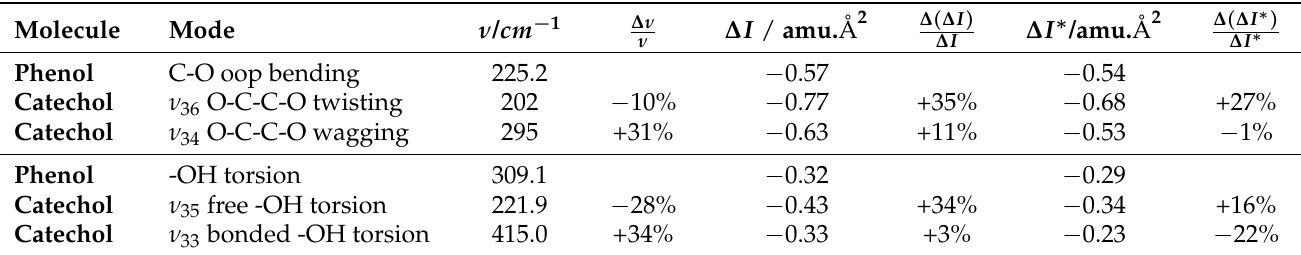
Table 6. Comparison of the vibrational band centres ν and the inertia defects ∆ I for the C-O oop bending and -OH torsional modes of phenol and catechol. The relative variations parameters issued from [27] are given in %. ∆ I ∗ = ∆ I ES − ∆ I GS corresponds to the inertia defect corrected by the GS value, i.e., induced by the oop